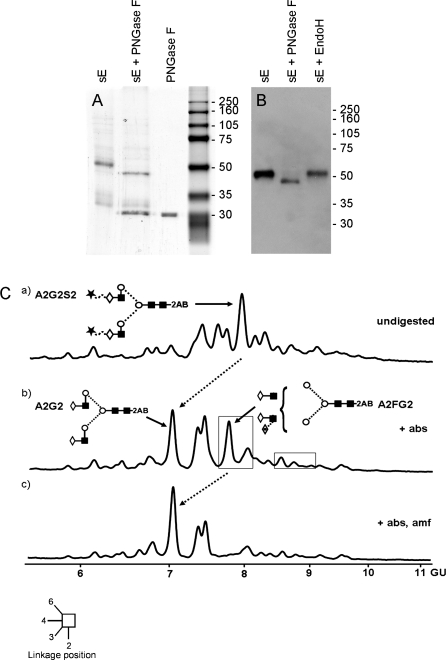
Production and Characterisation of Recombinant Soluble Dengue Virus E-Glycoprotein(A) SDS-PAGE of sE protein preparation resolved on 10% gel and stained with Coomassie Brilliant Blue. Lane 1, sE preparation as eluted from NiNTA-agarose. Lane 2, PNGaseF-treated sE. Lane 3, PNGaseF alone.(B) Western blot of sE before (Lane 1) and after treatment with PNGaseF (Lane 2) or EndoH (Lane 3), resolved under reducing conditions by 10% SDS-PAGE, and probed with the anti-DV E monoclonal antibody, 3H5.(C) NP HPLC chromatograms of the complete pool of 2AB labelled glycans of sE glycoprotein, together with sequential digestions. a) Complete glycan pool, undigested, with structural representation of A2G2S2. b) Glycans digested with Arthrobacter ureafaciens sialidase (abs), which releases α2–6 and 3 linked sialic acids. Boxed sections show peaks containing α1–3 or 4 linked fucose residues, with structural representations of A2G2 and A2FG2. c) Glycans digested with abs and almond meal fucosidase (amf), which releases α1–3 and 4 linked fucose residues.Key: A2, biantennary; G, galactose; F, fucose; S, sialic acid. Filled square, N-acetyl glucosamine; open circle, mannose; open diamond, galactose; filled star, sialic acid; open diamond with dot, fucose. The solid lines are β-linkage, dotted lines are α-linkage, and curved lines are unknown linkage.